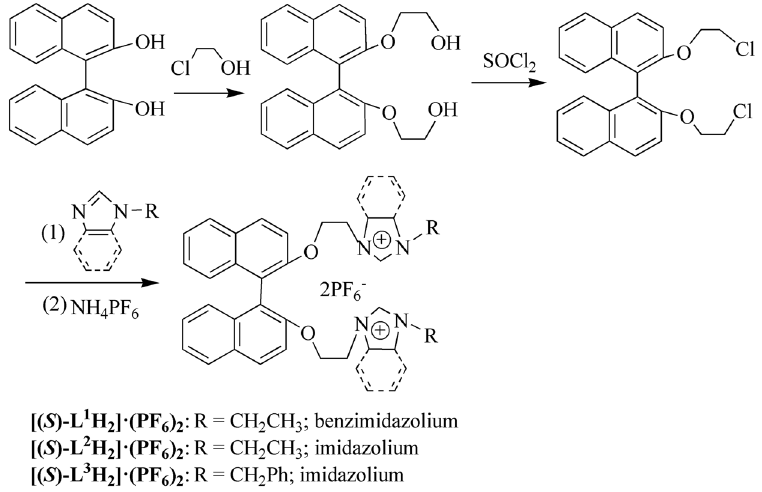
Figure 1. Preparation of precursors [( S )-L 1 H 2 ]·(PF 6 ) 2 -[( S )-L 3 H 2 ]·(PF 6 ) 2